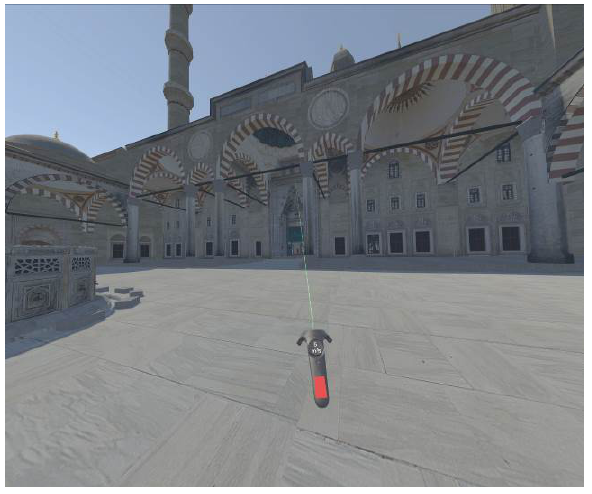
Fig. 12. The Virtual Reality System HTC Vive in action using navigation controller for the motion in the environment Fig. 11. Two examples for polygon reduction – original data before (left) and new data for the game engine after reduction (right)